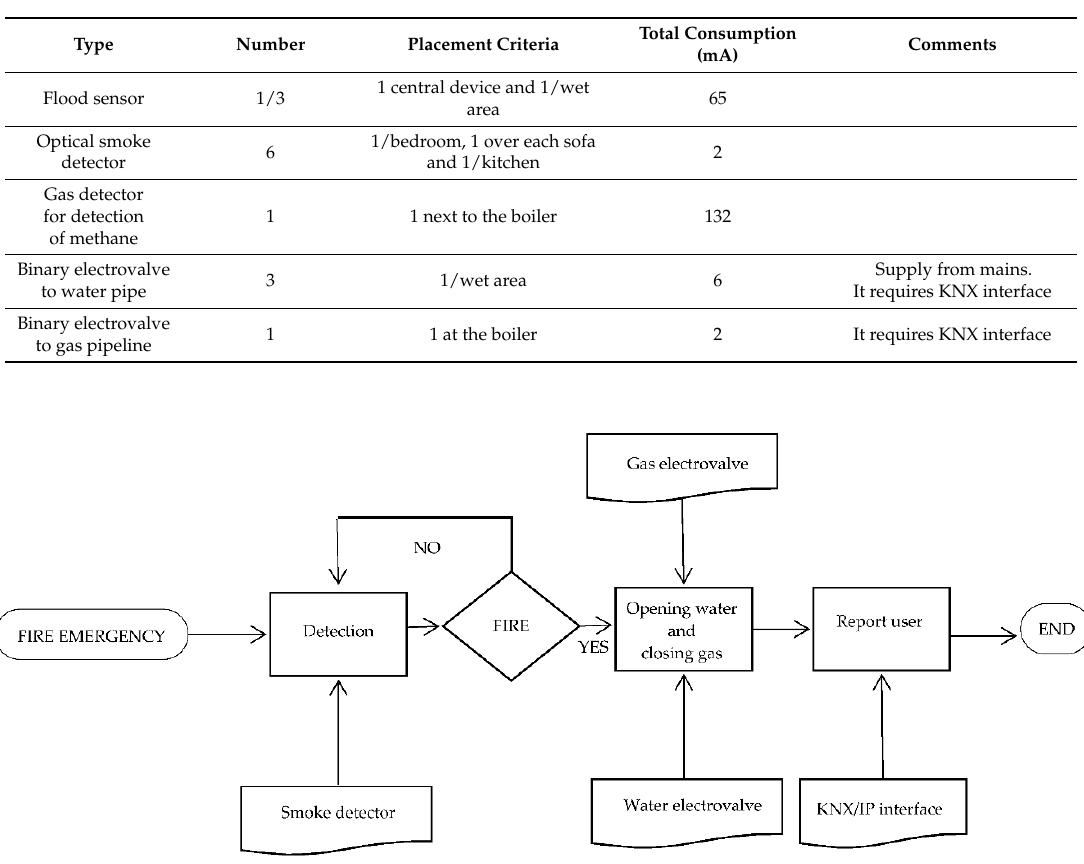
Figure 4. Flow chart of technical alarms subsystem functioning in case of fire emergency. Table 9. Installed sensors and actuators in advanced home automation system